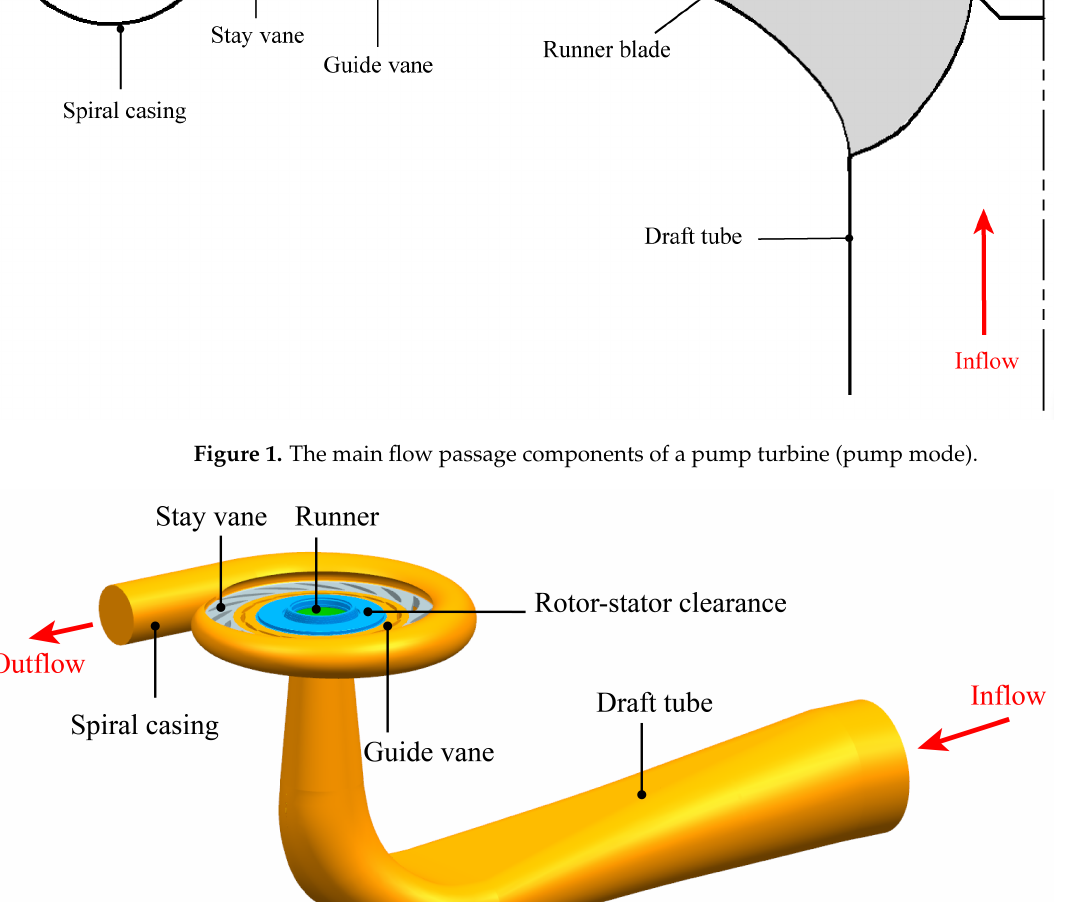
Figure 2. Flow passage model of a pump turbine (pump